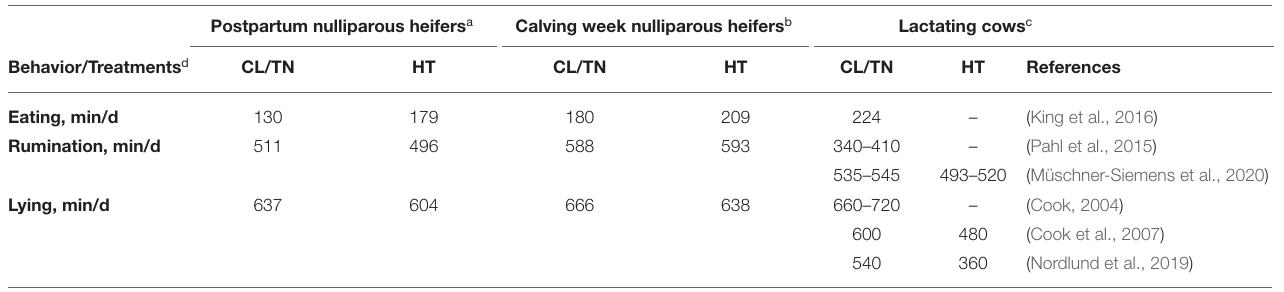
TABLE 2 | Eating, rumination, and lying times (min/d) automatically measured in postpartum nulliparous heifers and lactating cows. Postpartum nulliparous heifers